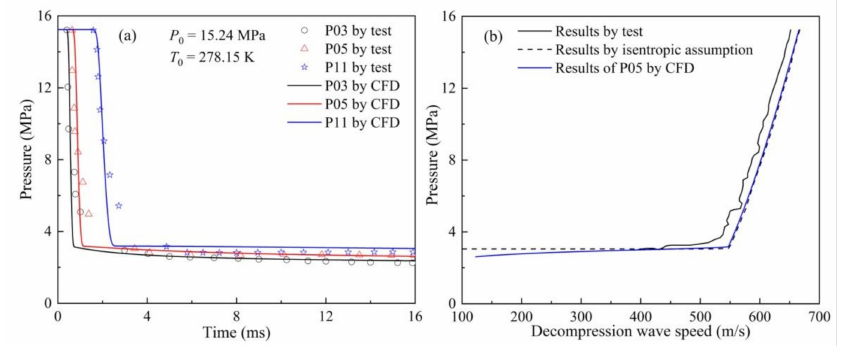
Figure 5. Comparison of ( a ) pressure and ( b ) decompression wave speed (the data points by test were from Cosham [17], and the evaporation coefficient and condensation coefficient were both 15 s − 1 in the CFD